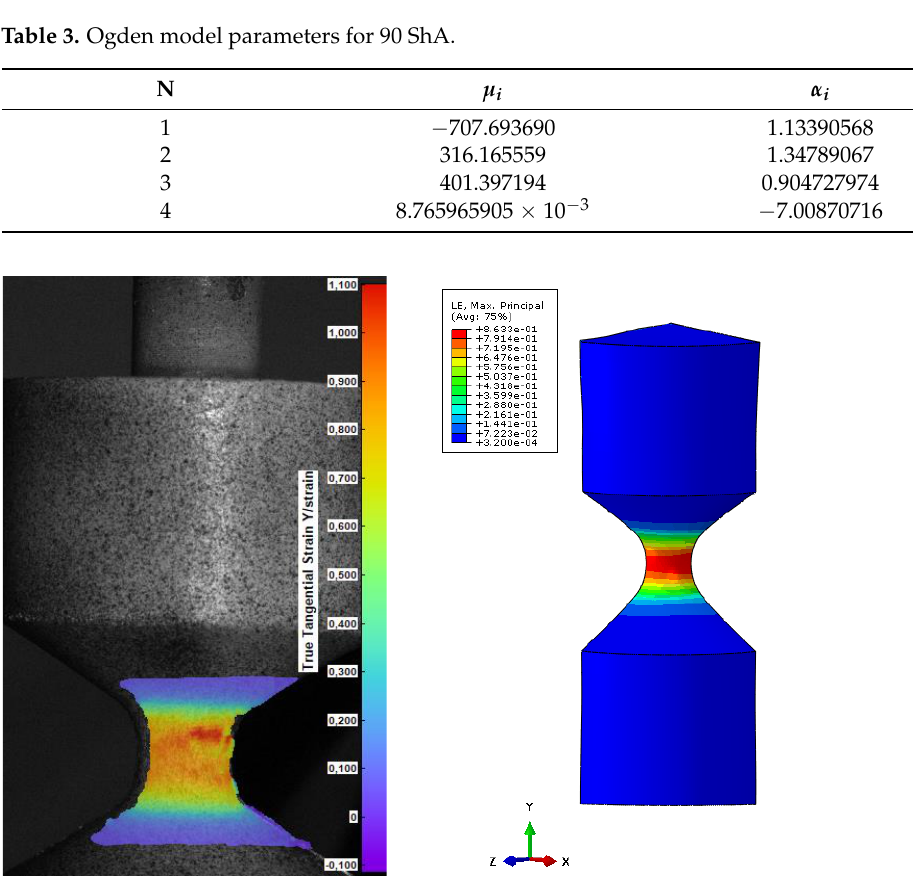
Figure 11. Comparison of DIC and FEM in terms of the obtained value of strain for step 60 (force DIC = 591 N, FEM force = 828 N).